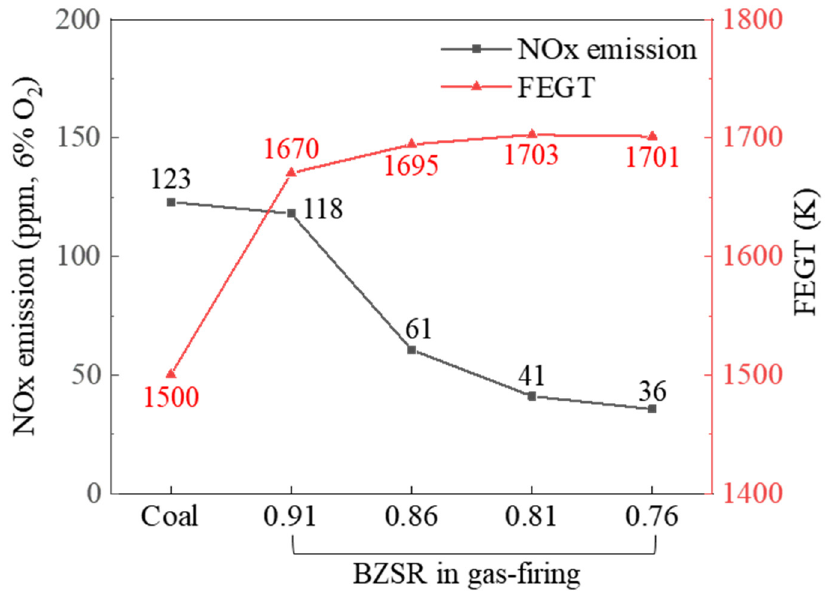
Figure 11. NOx emissions and furnace exit gas temperature (FEGT) under coal- and gas-firing cases.